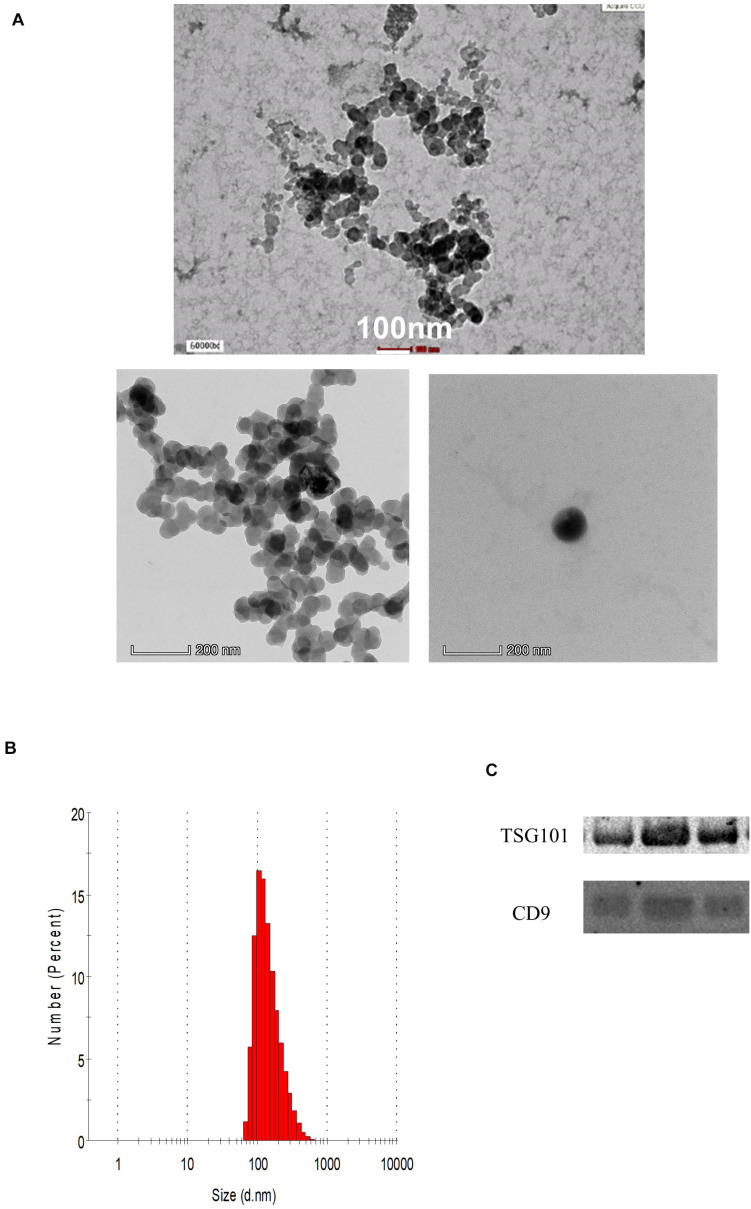
(A) Representative transmission electron microscopy images of the enriched population. (B) Representative histogram of the dynamic light scattering (DLS) measurement of the EVs. (C) Western blot analysis of representative CRC EVs targeting TSG101 and CD9 proteins.